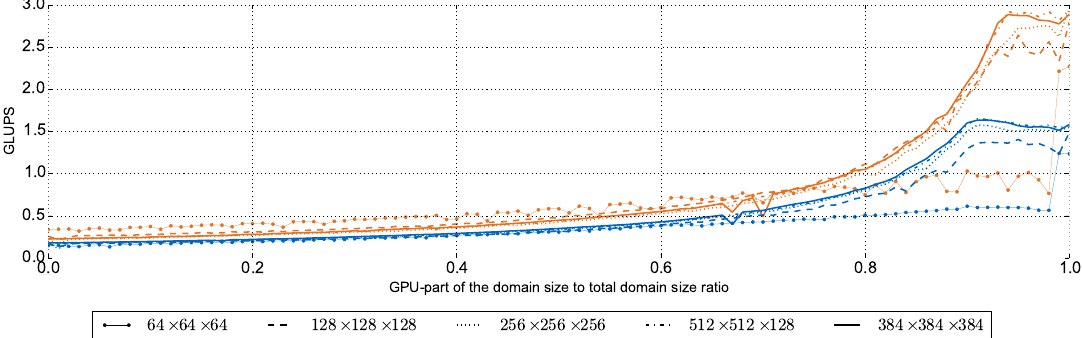
Figure 9. Performance in GLUPS of a heterogeneous system in dependence of the size of the GPU-part of the domain. Size is given as share of the GPU-part in the total subdomain ranging from 0 (100%/0% CPU/GPU ratio) to 1 (0%/100% ratio). The CPU-part is processed by a Intel Xeon E5-2690v3, the GPU-part by a NVIDIA Tesla P100. Different lines depict different domain sizes. Single and double precision are colored in orange and blue,